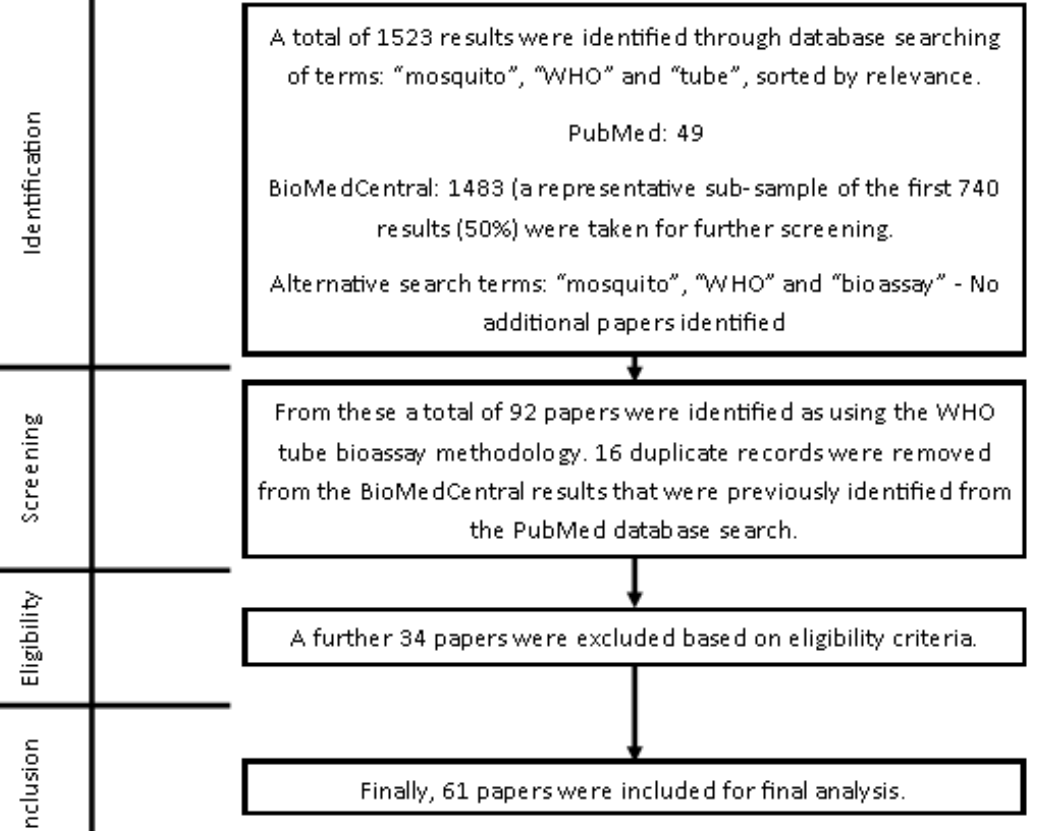
Figure 1. Flow diagram describing methodology of the literature review.